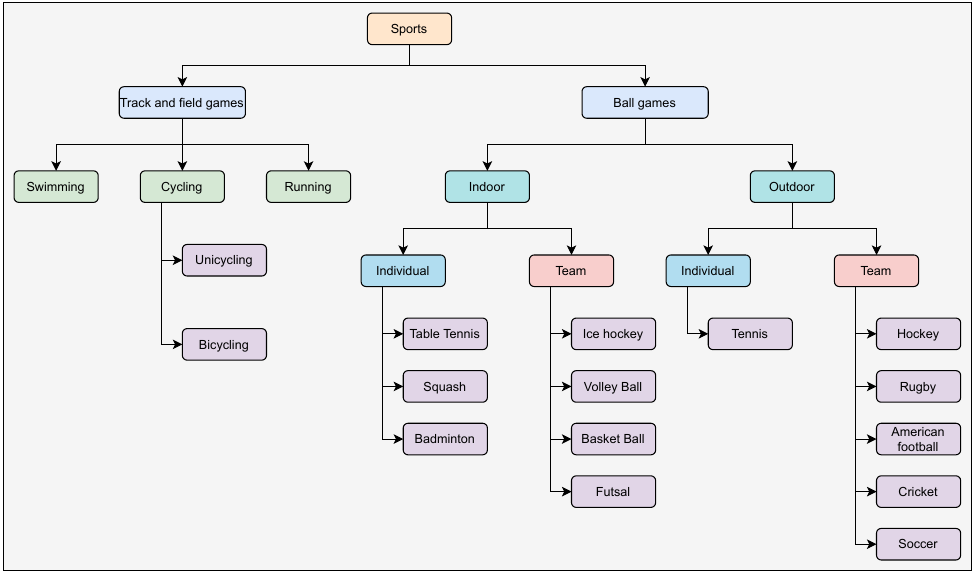
Figure 1. Classification of different types of